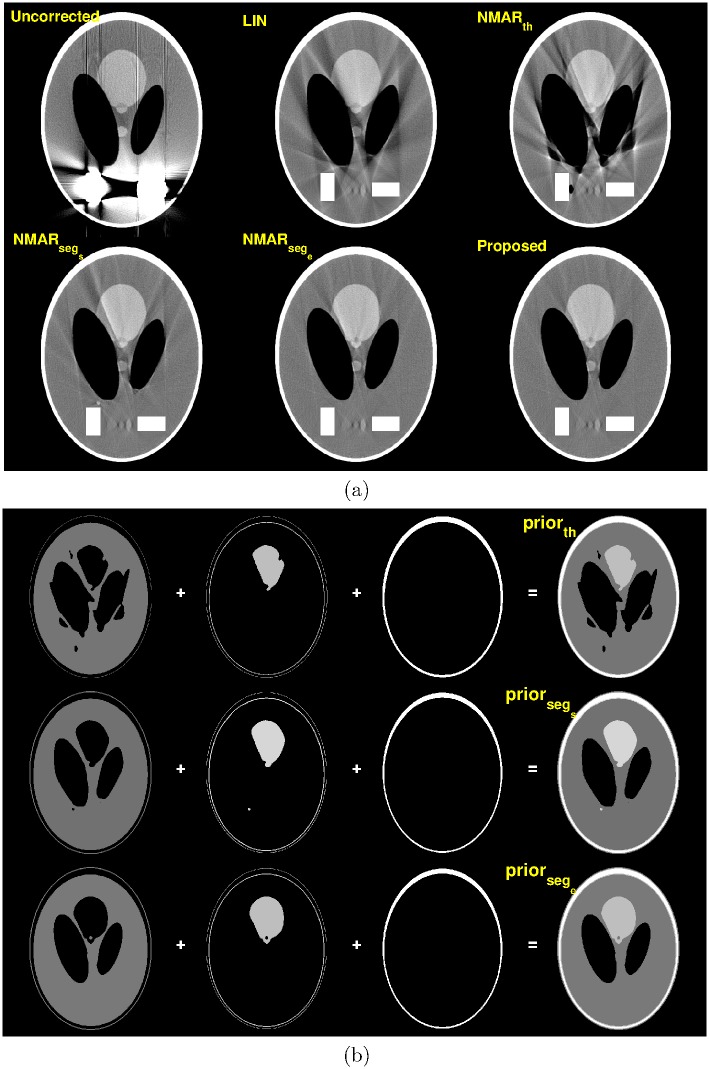
Results of the Shepp-Logan phantom (C = 250 HU/W = 750 HU).(a) Top row: reconstruction images by (left) Uncorrected, (middle) LIN, and (right) NMARth images. Bottom row: reconstruction images by (left) NMARsegs, (middle) NMARsege, and (right) the proposed MAR. (b) Prior images by (top) simple thresholding, (middle) RAC segmentation of the LIN image, and (bottom) RAC segmentation of the final iteration image.